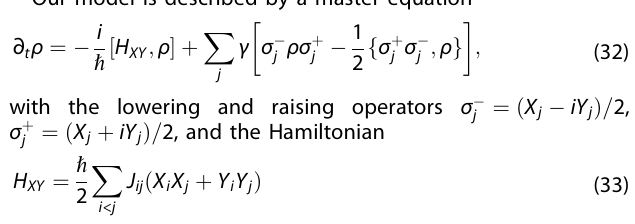
Fig. 3 Symmetry resolved entanglement detection in quench dynamics with spin excitation loss. We study SR-entanglement in quench dynamics in a system consisting of N = 8 spins initialized in a Néel state #"j i (cid:2) N = 2 and evolved with H XX subject to spin excitation loss with various rates γ ( γ / J increases with the darkness of the color, see insets). We take A = [1, 2, 3, 4] and B = [5, 6, 7, 8]. In panels ( a ) and ( b ), the D 2 ratio and p 3 -PPT ratio of sector q = − 1 are shown, respectively. Entanglement is detected for values below unity in the shaded gray areas. The insets in ( a ) and ( b ) show the early time value at t = 0 + of the D 2 -ratio a) and p 3 -PPT ratio ( b ), respectively, as a function of the decoherence rate γ / J . Black lines are the perturbation theory results displayed in Eqs. (40) and